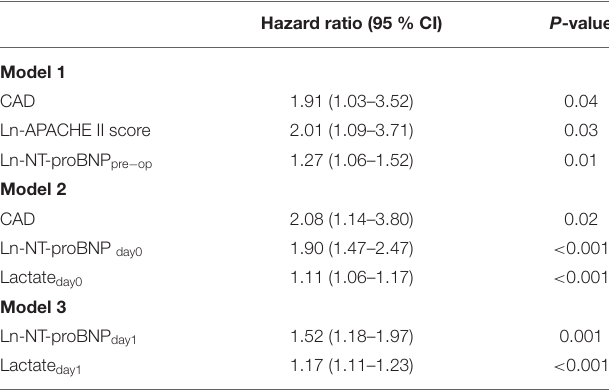
TABLE 6 | Independent predictors of 28-day mortality by multivariate Cox regression analysis. Hazard ratio (95 % CI) P